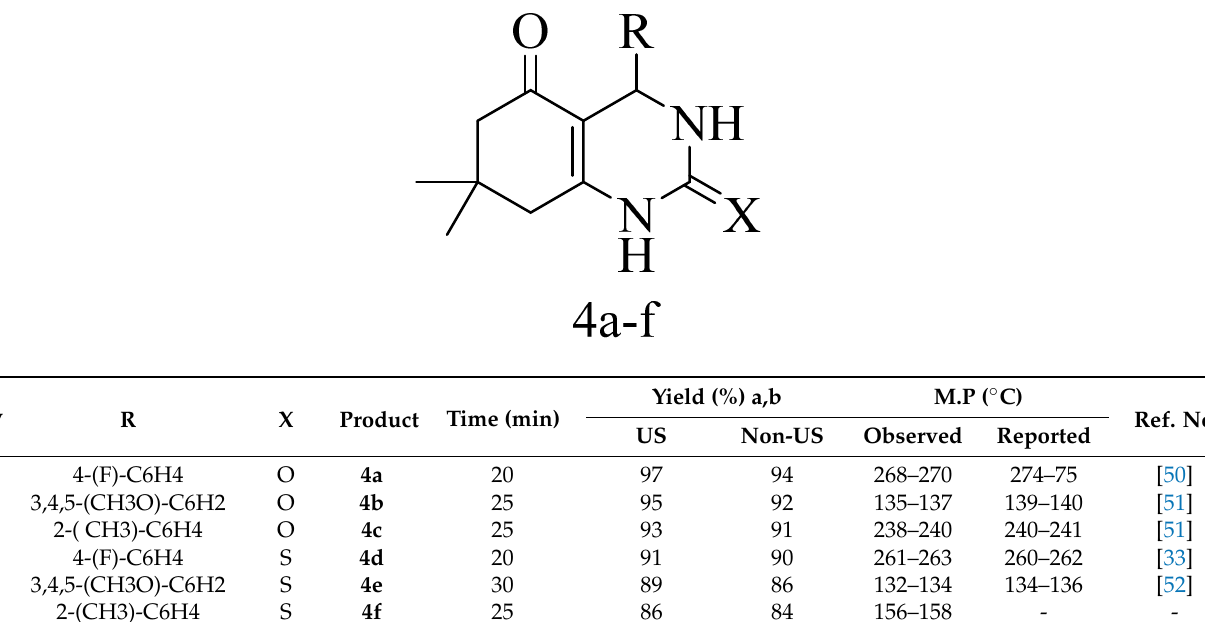
Table 4. The synthesis of octahydroquinazolinones (4a-f) derivatives catalyzed with 1%Pd-HPW/SiO 2 .